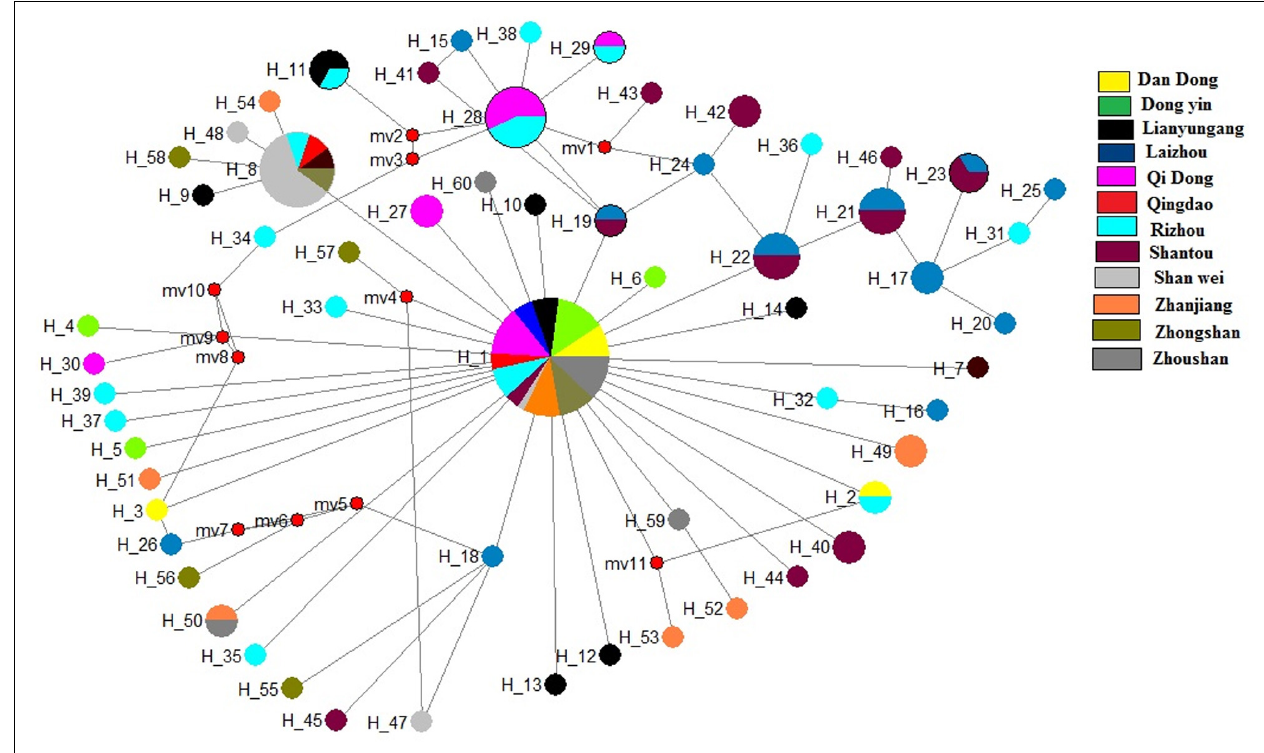
FIGURE 4 | Median-joining networks of Konosirus punctatus developed using COI data. Color representation is showing the population frequency. Shown numbers are representing the haplotype numbers.